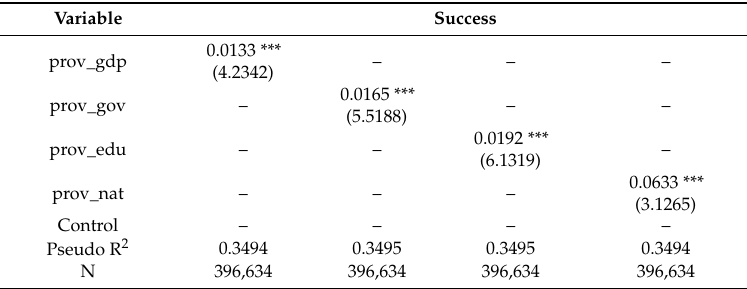
Table 10. Empirical analysis of the causes of regional discrimination (probit